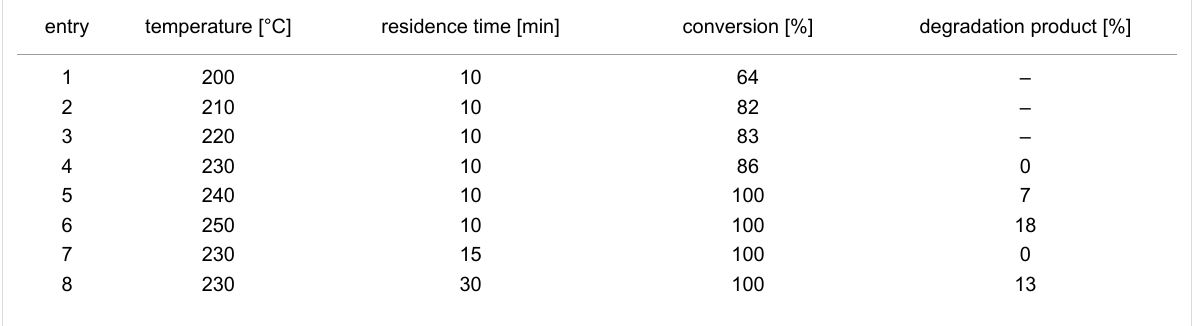
Table 1: Reaction parameter optimization for the CF rDA reaction of 1